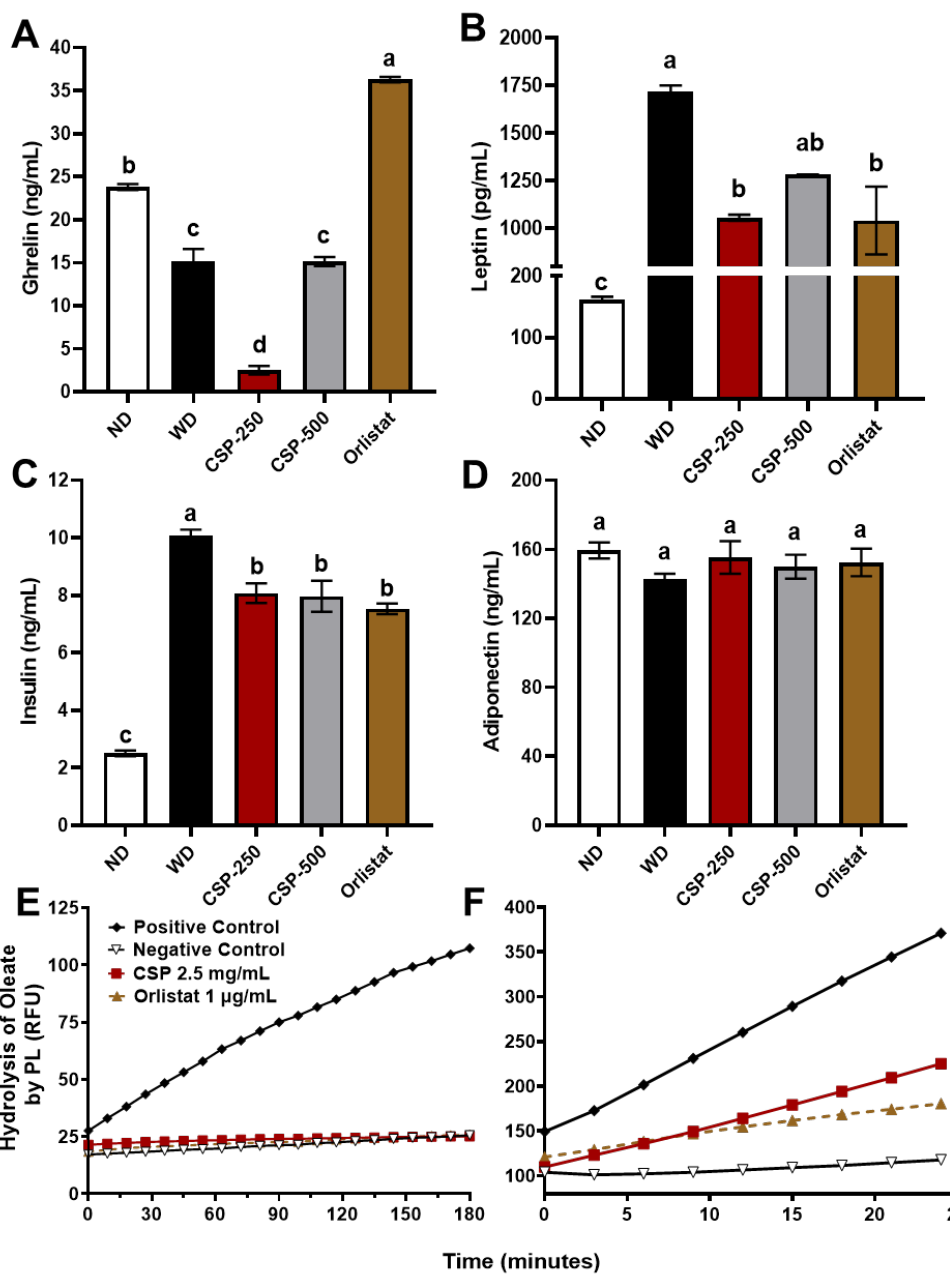
Figure 3. Effects of canary seed peptides (CSP) administration on regulation of metabolic hormones after eight weeks of diet-induced intervention in C57BL/6J mice and inhibition against pancreatic lipase (PL). Fasting serum levels of ghrelin ( A ), leptin ( B ), insulin ( C ), and adiponectin ( D ) hormones. Complete inhibition of PL by CSP and orlistat ( E ). 20-fold dilution of PL-inhibitor complex with oleate promotes recovery of PL activity from PL-CSP complexes ( F ). ND, normal diet; WD, Western diet; CSP-250, mice supplemented with 250 mg/kg of body weight of CSP; CSP-500, mice supplemented with 500 mg/kg of body weight of CSP; Orlistat, mice supplemented with 40 mg/kg of body weight of orlistat. Bars and lines represent mean values ± SEM ( n = 8 per treatment). Different letters (a – d) indicate statistical differences ( p < 0.05) between treatments.